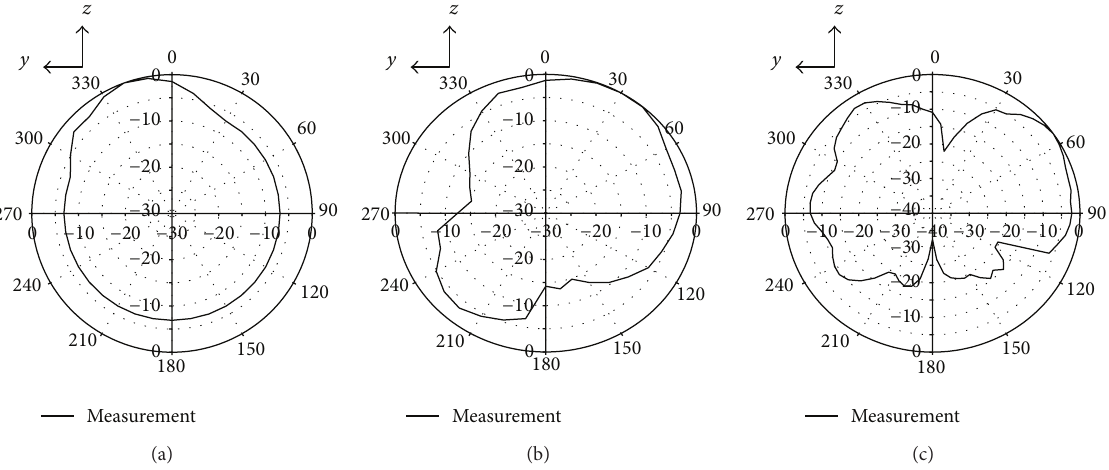
Figure 10: Measured radiation pattern of the proposed antenna at 2.39 GHz. (a) R-RFS B, and C are ON. (b) R-RFS A, B and C are ON. (c) R-RFS A and C are ON. The R-RFS that not was mentioned is in OFF